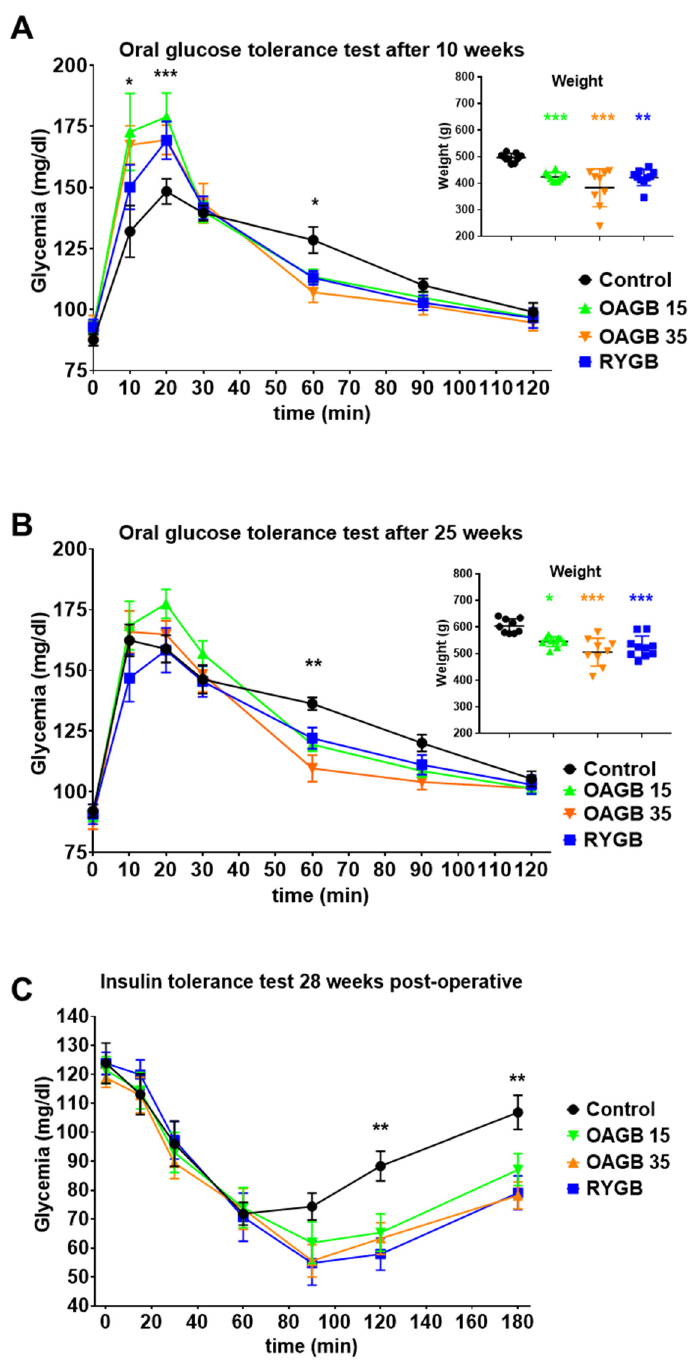
Figure 4. Shortening the BPL of OAGB maintains amelioration of glucose control in non-obese rats . ( A , B ) Glycaemia during an oral glucose tolerance test performed on week 10 ( A ) or 25 ( B ) post-surgery * p < 0.05 and ** p < 0.01, for control (black) animals versus animals operated on bariatric surgery by Dunnett’s multiple comparison tests after 2-way RM ANOVA. Inserts: corresponding weight of the animals * p < 0.05; ** p < 0.01, *** p < 0.001 for OAGB-15 (green) OAGB-35 (orange) or RYGB (blue) vs. Control (black) animals by Dunn’s multiple comparison tests after Kruskal–Wallis Test. ( C ) Glycaemia during an insulin tolerance test performed on week 28 post-surgery. ** p < 0.01 for control (black) animals versus animals operated on bariatric surgery by Dunnett’s multiple comparison tests after 2-way RM ANOVA. Data are expressed as means ± SEM, Control n = 8, RYGB n = 10, OAGB15 n = 11, OAGB35 n = 10.